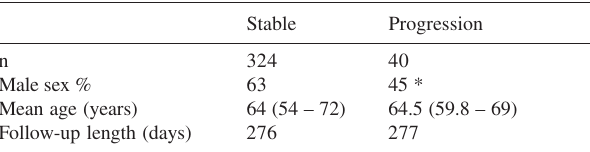
Table 1 - Demographic data of both groups